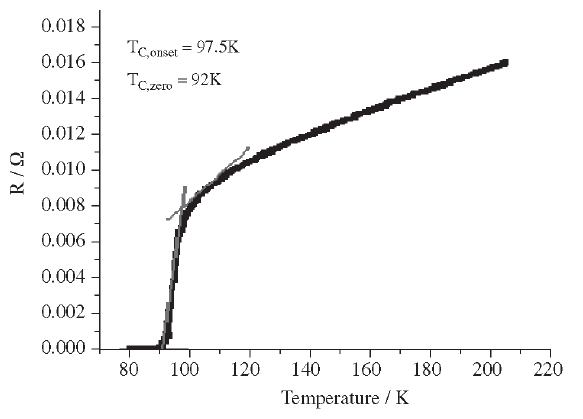
Figure 8. Resistance versus temperature for the Bi